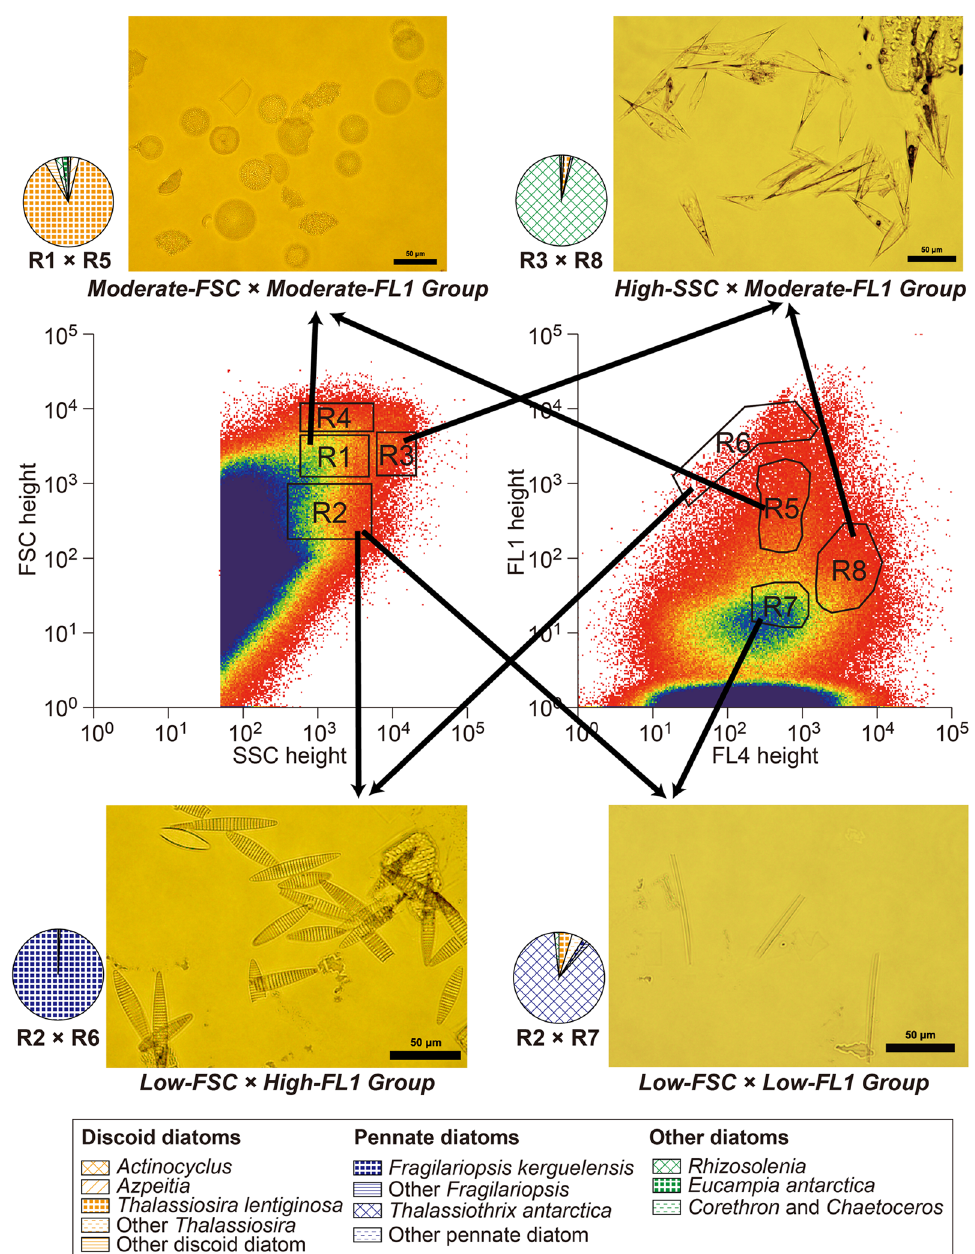
Fig. 5 Flow cytograms of sample 382-U1538A-1-2, 24–25 cm (Holocene) and pie charts/photomicrographs showing the diatom assemblages obtained by sorting of the following composite regions: Regions 1 and 5 (discoid-diatom-rich); Regions 2 and 6 ( Fragilariopsis -rich); Regions 3 and 8 ( Rhizosolenia -rich); and Regions 2 and 7 ( Thalassiothrix -rich). The crystalline materials in the micrographs are NaCl crystals in the sheath